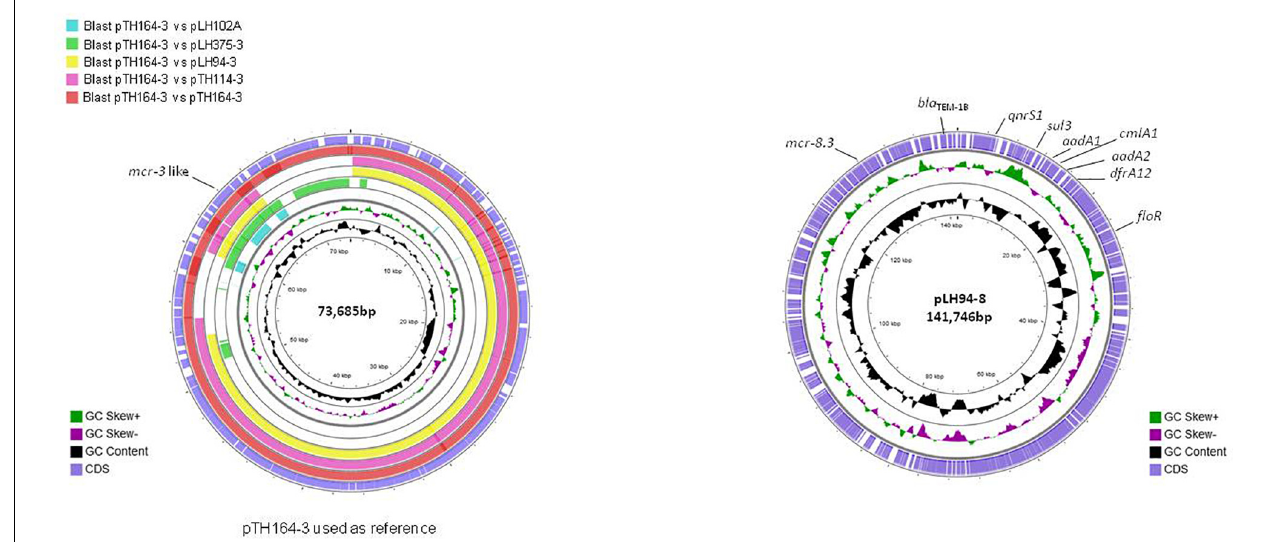
FIGURE 2 | Circular representation of the five complete mcr-3 plasmids (left) and the mcr-8 plasmid (right) . Figure constructed using CGView software.